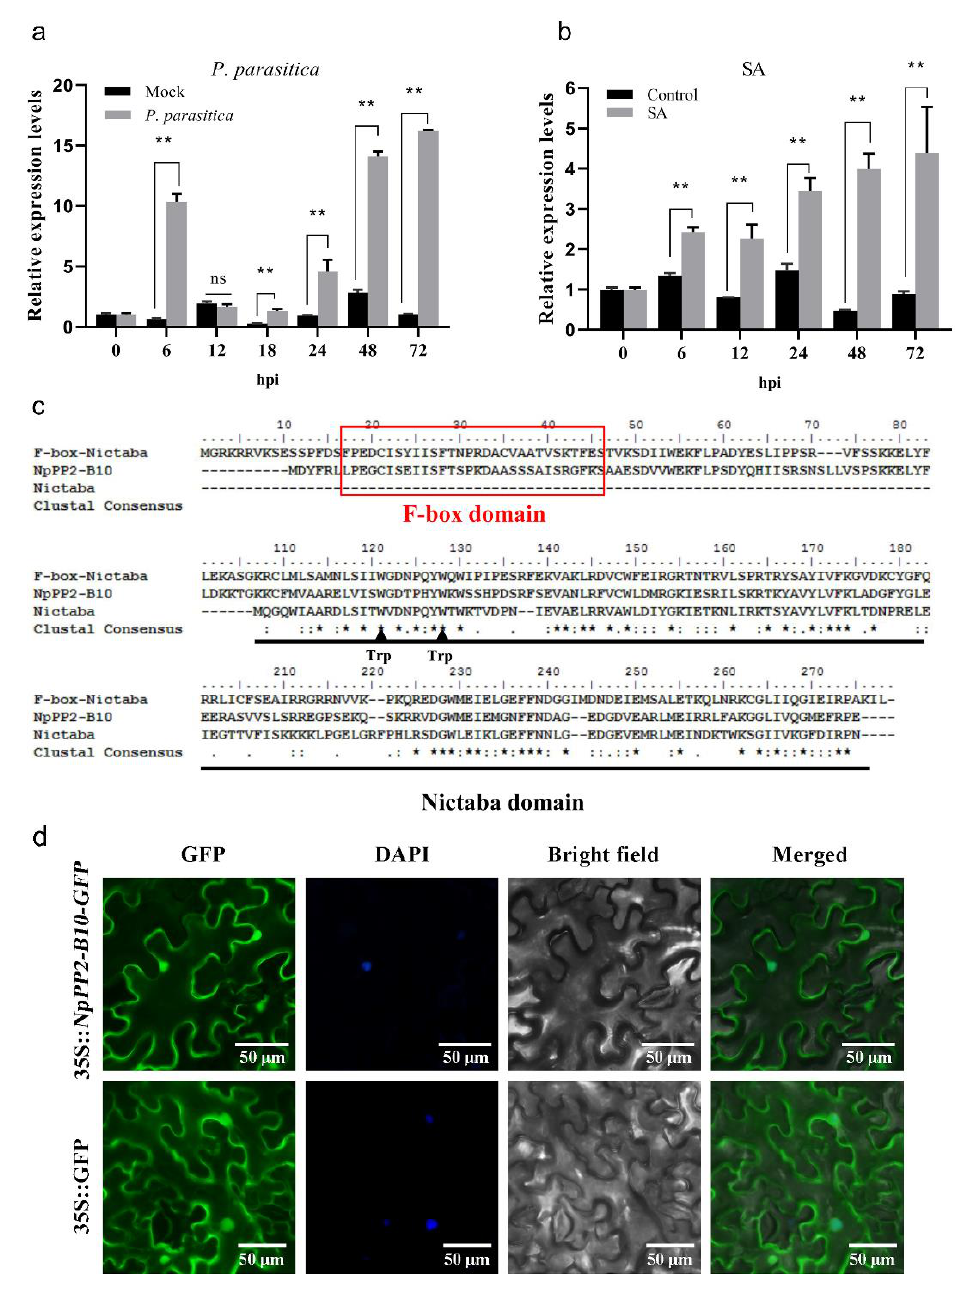
Figure 1. Characterization of NpPP2-B10 . ( a , b ) Expression pattern of the c62451.graph_c0 gene in tobacco treated with P. nicotianae race 0 and SA. Asterisks denote significant differences (compared with the control group): ** p < 0.01, by Student’s t -test; ns, no significant difference. ( c ) Sequence alignment of NpPP2-B10 with the F-box-Nictaba protein of Arabidopsis thaliana and the Nictaba protein of N. tabacum. ★ The exact same residue; : residues that are particularly similar in nature; . residues that are slightly similar in nature. ( d ) The subcellular localization of NpPP2-B10 in N. benthamiana epidermal cells. GFP: Green fluorescent protein. DAPI: Nucleic marker. Merged: Merged image of the bright field, GFP, and DAPI results. The above image is a random field of view taken from a fluorescent region of the tobacco epidermis.